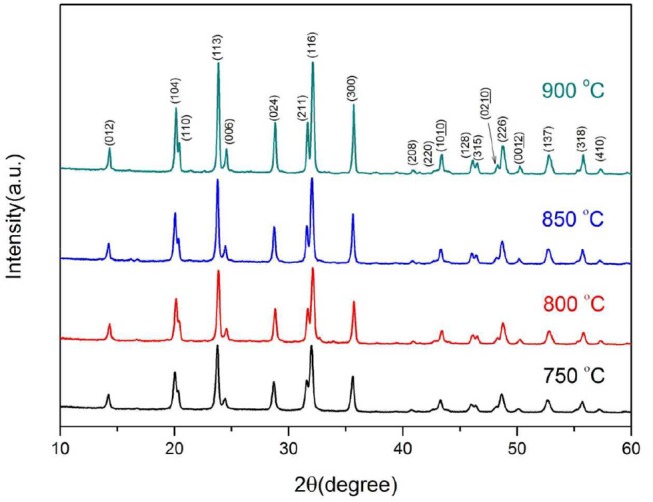
XRD patterns of Na3V2(PO4)3/C synthesized at different temperatures.